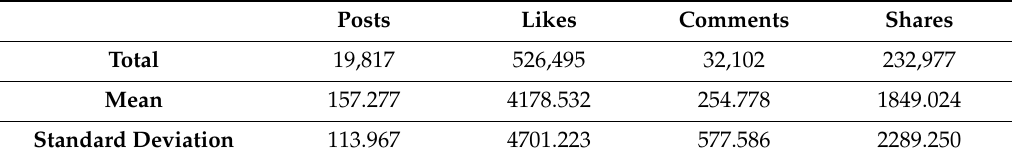
Table 4. Posts’ quantitative parameters.